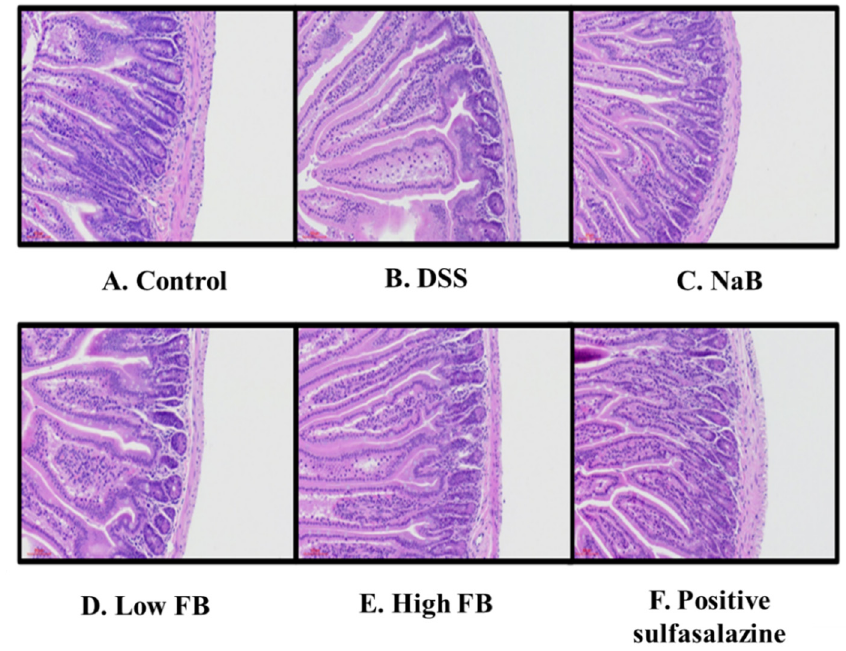
Figure 4. Morphological analysis of the large intestine of FB in colitis mice. All animals were admin- istered oral during the recovery period. ( A ) Control ( B ) DSS-induced model ( C ) Sodium butyrate (Sigma-Aldrich), ( D ), Low concentration (50 mg/kg) of FB. ( E ), High concentration (100 mg/kg) of FB. ( F ), Positive control (sulfasalazine, 50 mg/kg).